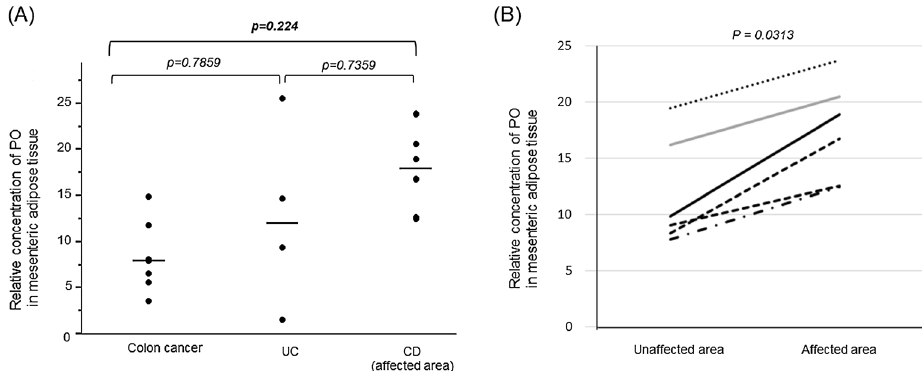
Figure 4. Palmitoleic acid (PO) levels increase in the mesenteric adipose tissue (MAT) of patients with Crohn’s disease (CD). ( A ) Comparison of PO levels in the MAT among patients with colon cancer, ulcerative colitis (UC), and CD. PO levels in the MAT in the disease-affected area. The p-values in the graph show significant differences determined using the Steel–Dwass test. ( B ) Comparison of PO levels in the MAT between unaffected and disease-affected areas in patients with CD. p = 0.0313, paired Wilcoxon